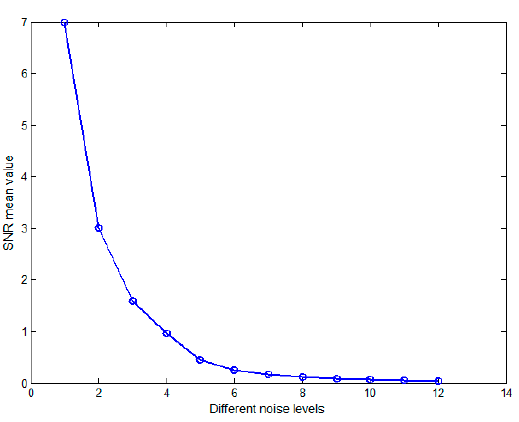
Figure 2. The SNR mean value of the simulated sensor data at twelve different noise levels.